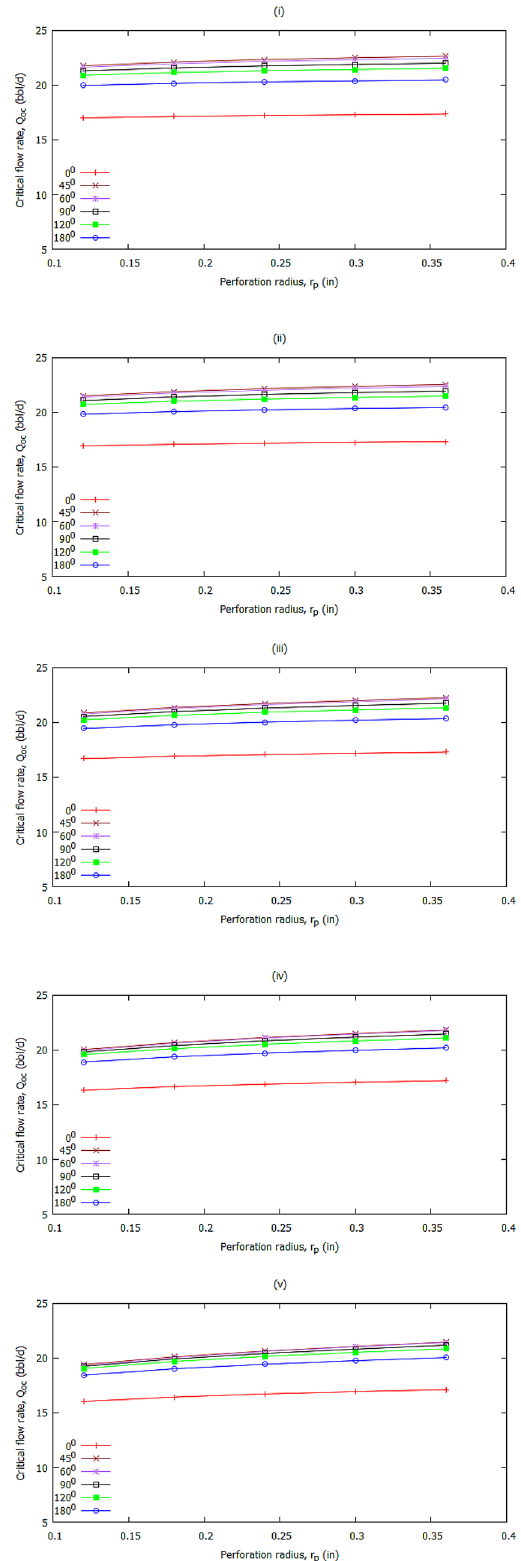
Fig. 7 Perforation length of 42 in and spacing between perforations on critical flow rate at different phasing angles and perforation radius. i Spacing between perforations at 1 in, ii Spacing between perfora- tions at 1.2 in, iii Spacing between perforations at 1.7 in, iv Spacing between perforations at 2.4 in and (v) Spacing between perforations at 3